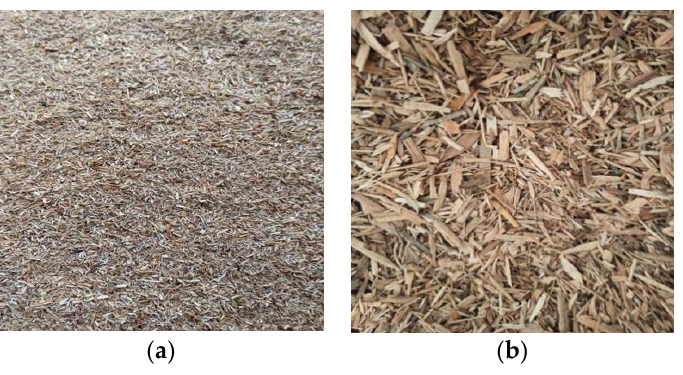
Figure 1. Appearance of the wood particles used for outer layers ( a ), core layer ( b ).